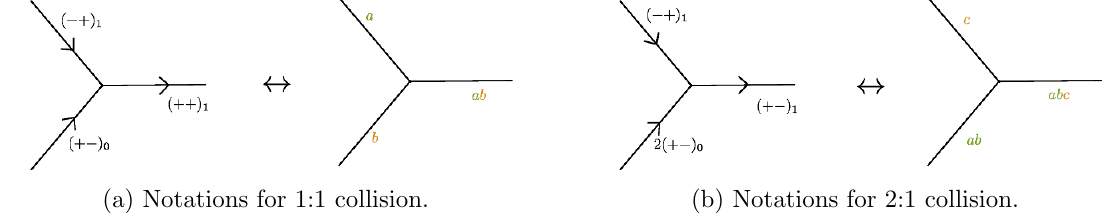
Figure 34. Converting between ( ij ) n and tree module notation.